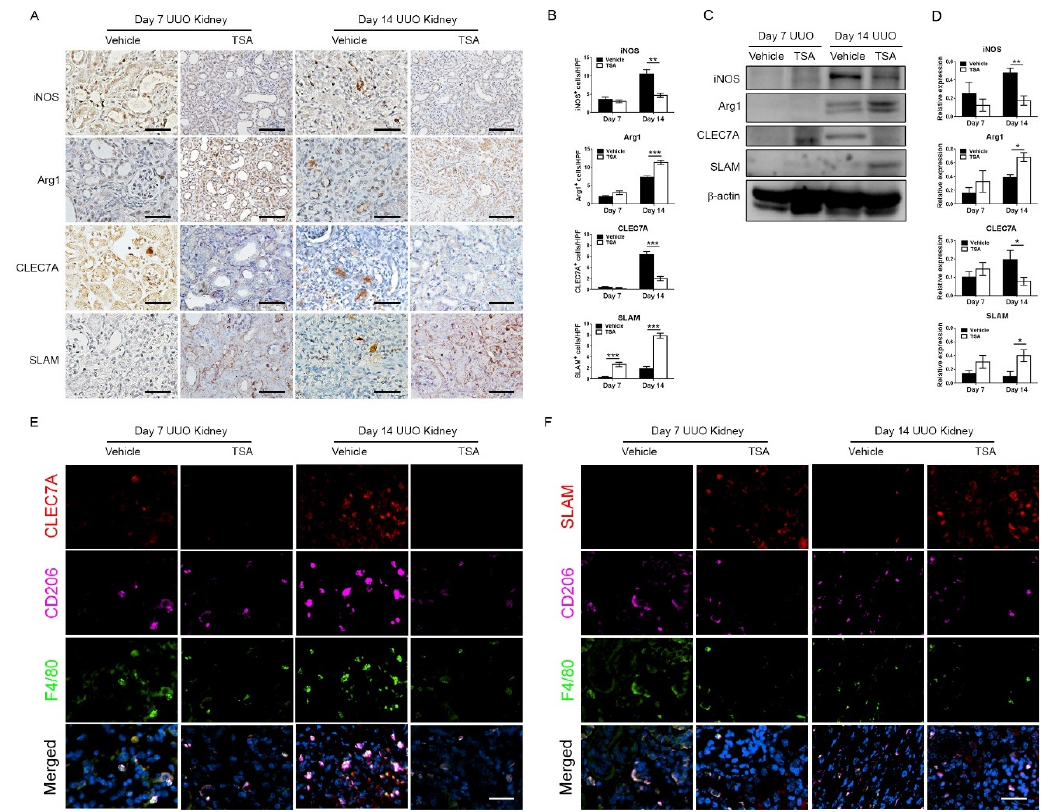
Figure 4. Trichostatin A (TSA) suppresses M1 and M2a macrophage infiltration but promotes